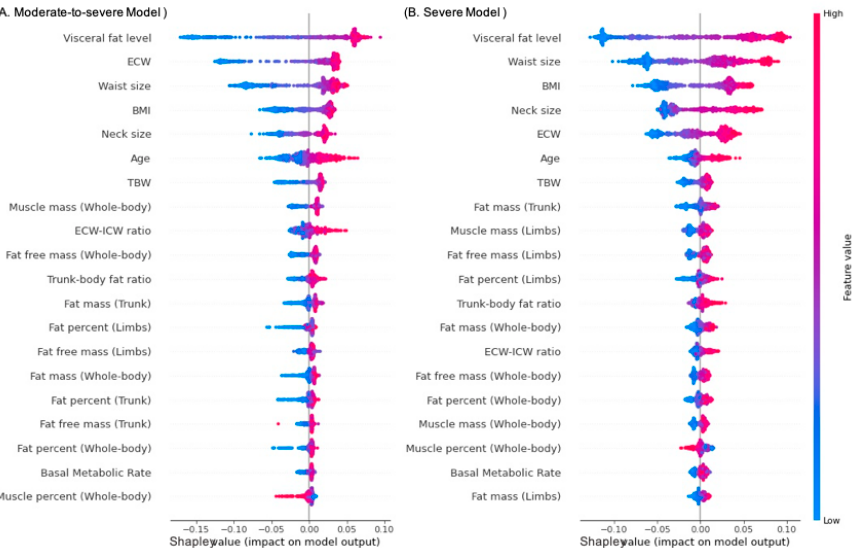
Figure 2. Density scatterplots representing Shapley values of input parameters for the RF models for screening moderate to severe and severe risks of OSA with the testing data set: ( A ) moderate-to- severe OSA model and ( B ) severe OSA model. Abbreviations: BMI, body mass index; TBW, total body water; ECW, extracellular water; ICW, intracellular water